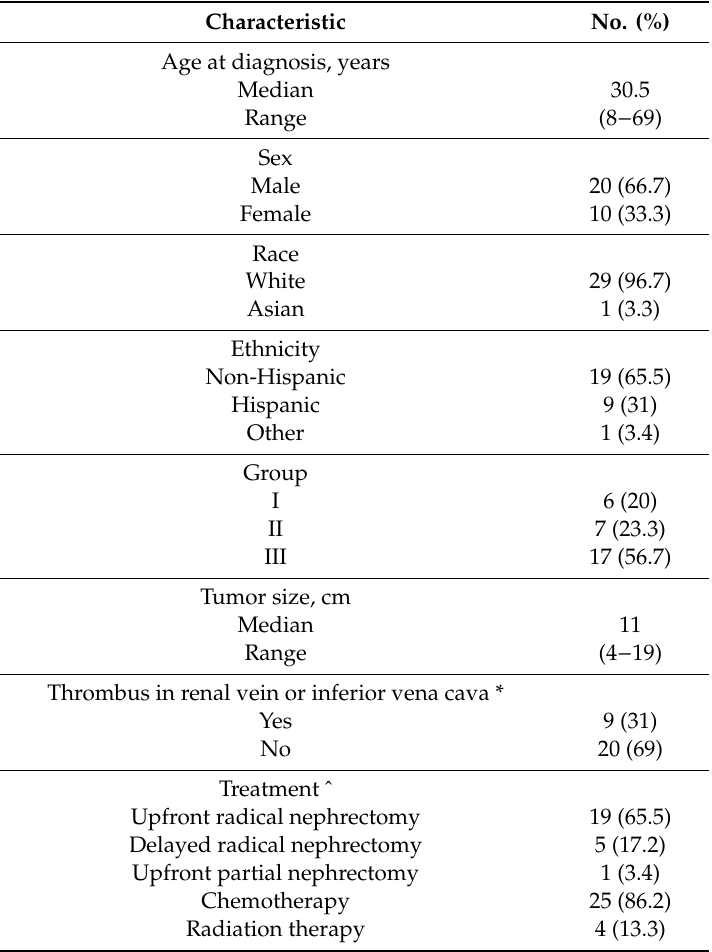
Table 1. Clinical Characteristics of 30 Patients with Primary ESFT of the